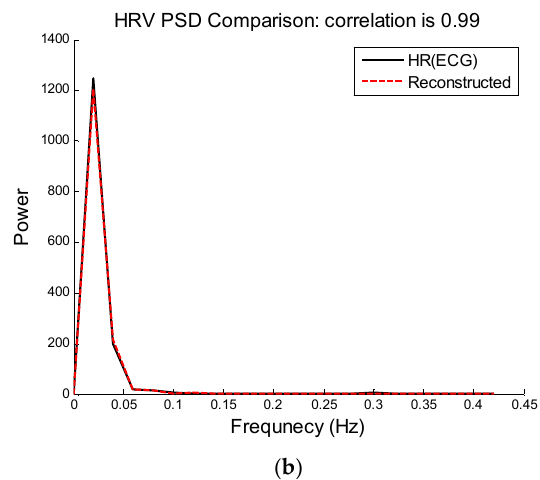
Figure 7. Heart rate variability analysis. ( a ) Time-domain comparison of reconstructed and reference HR. ( b ) Spectral comparison of heart rate variability between reconstructed HR and reference HR calculated from the reference ECG using Pan & Tompkins peak detection approach [32].